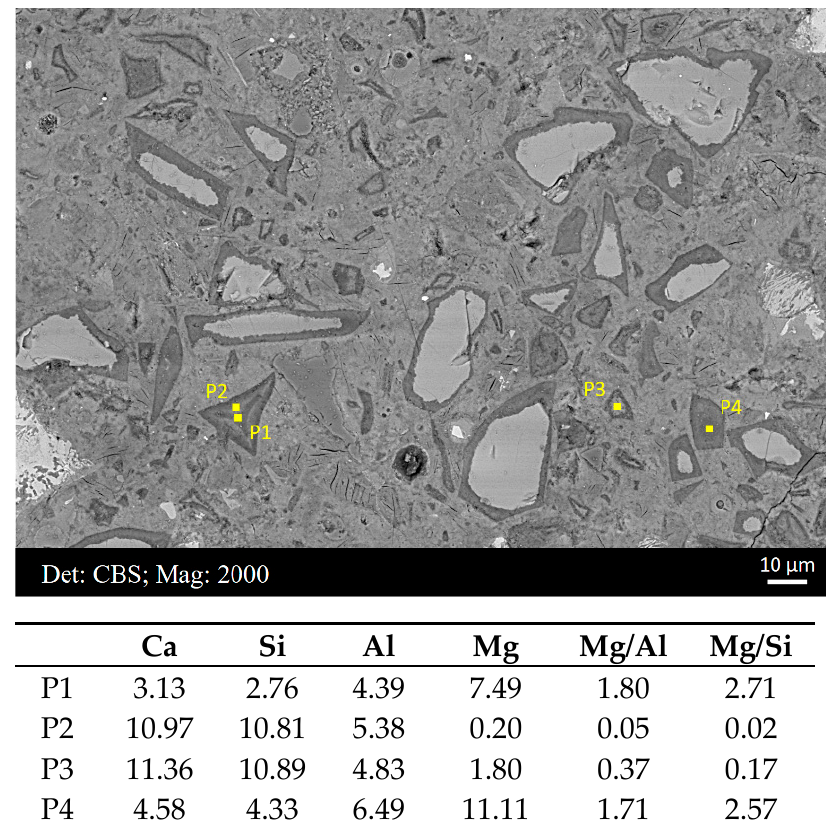
Figure 5. Some typical scatter points extracted from the point analysis of sample B, with elemental compositions exhibited in the table below.